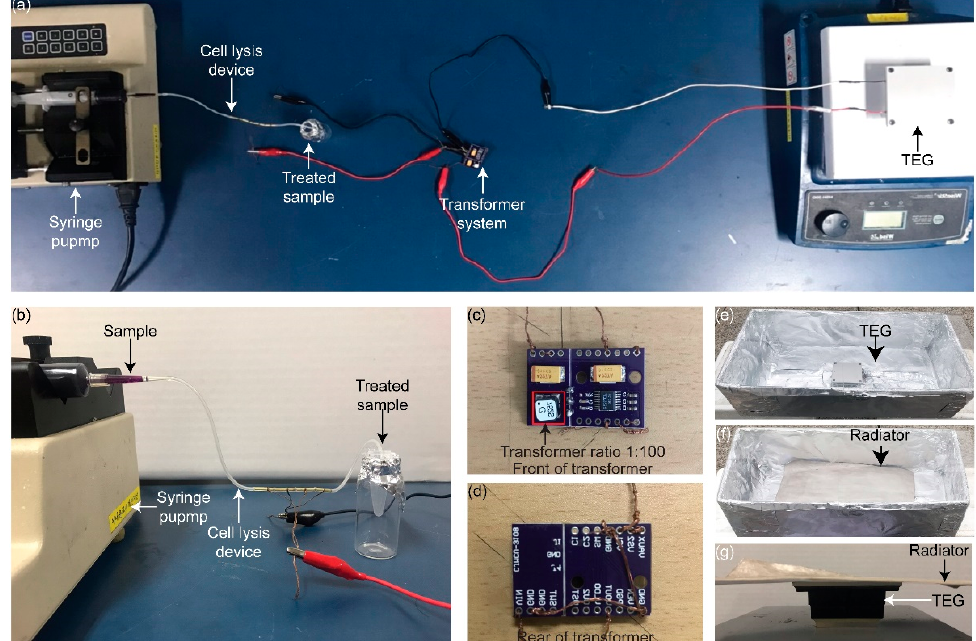
Figure 4. ( a ) Details of connections between devices, ( b ) connection of microfluidic device, ( c ) con- nections at the front of the transformer system, ( d ) connections at the rear of the transformer system, ( e ) position of TEG inside the insulated box, ( f ) radiator setup inside the insulated box, and ( g ) po- sition of radiator and TEG.